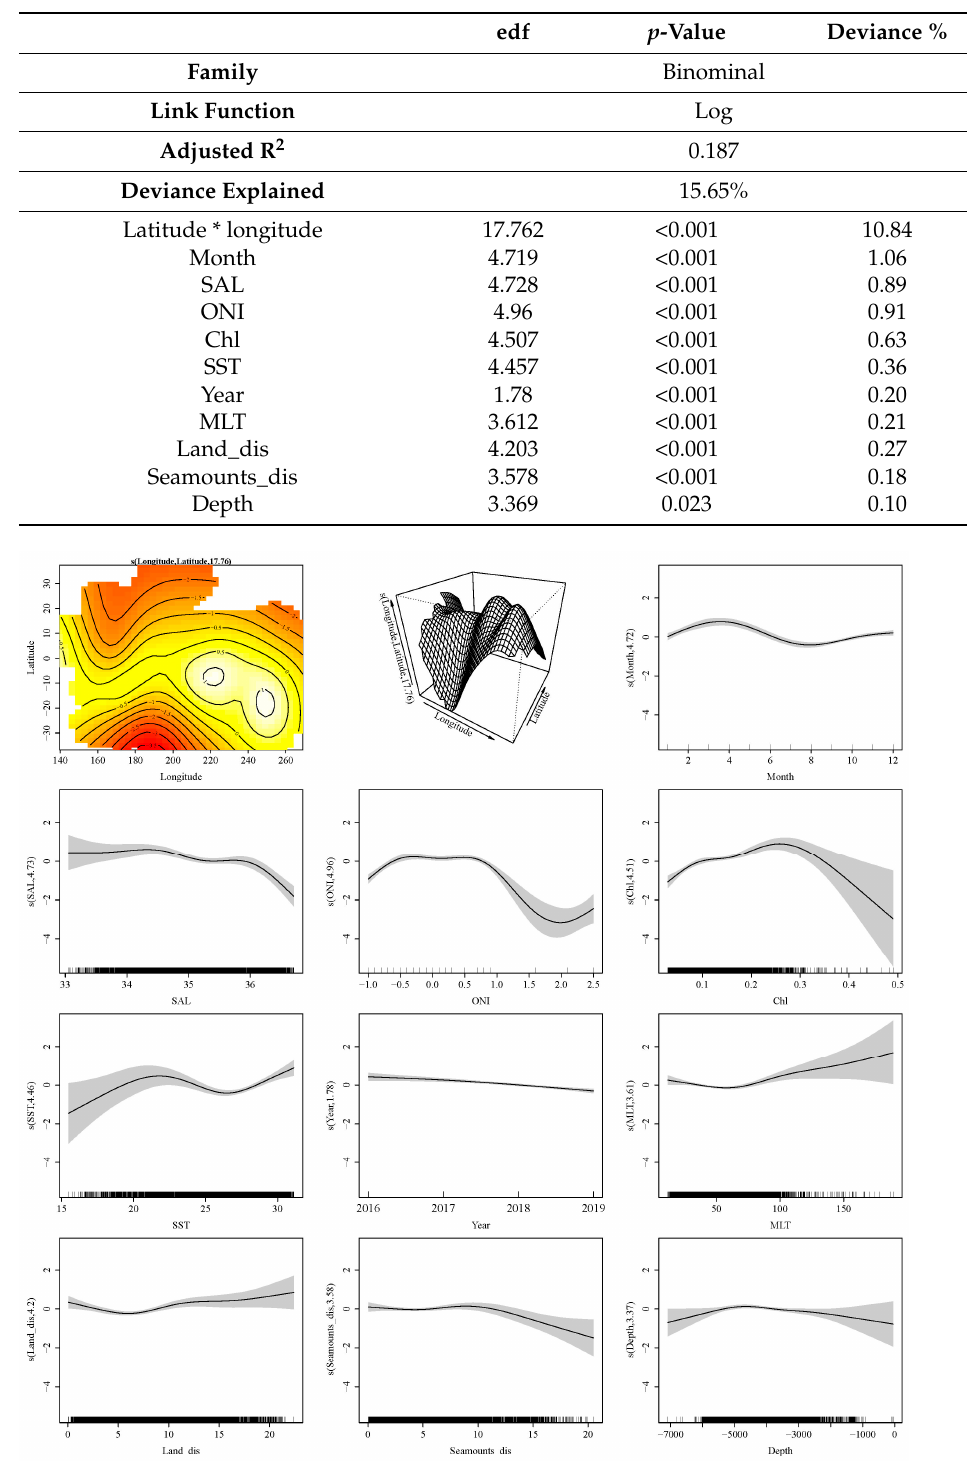
Table 3. Summary analysis of the deviance of the generalized additive model.